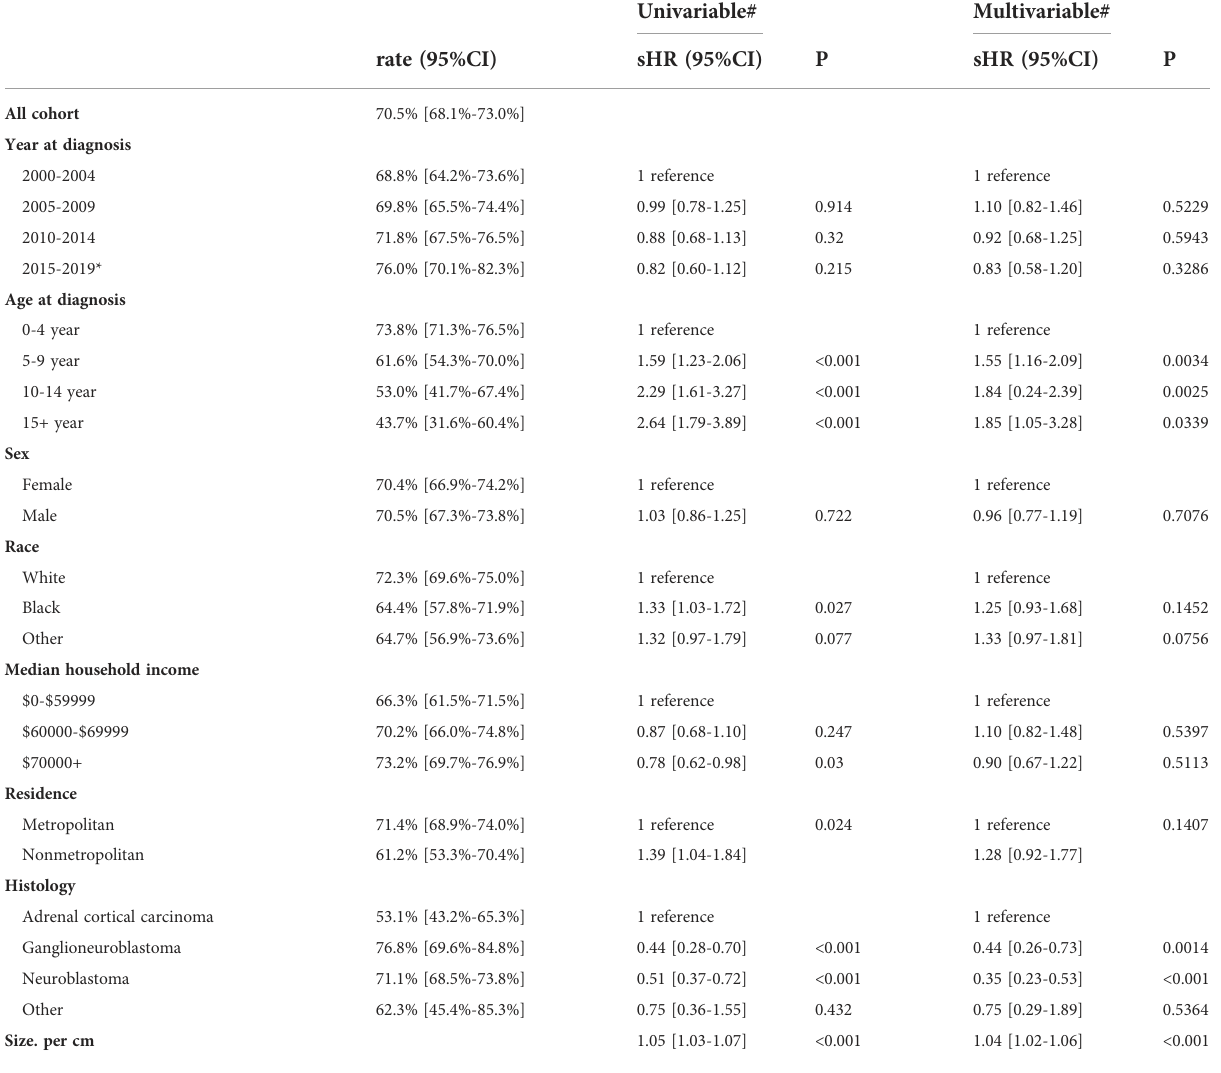
TABLE 3 Five-year cancer-sQecial survival and Qredictors of mortality by adrenal